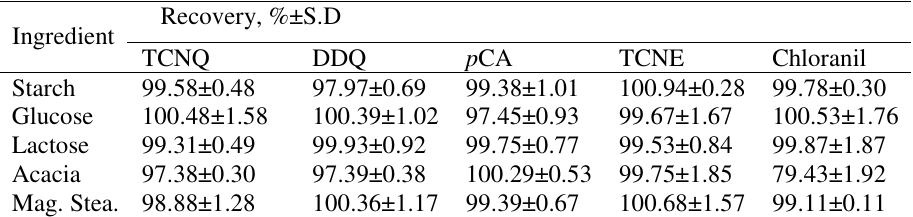
Table 4 . Analysis of pregabalin (PRE) in the presence of common excipients by different methods